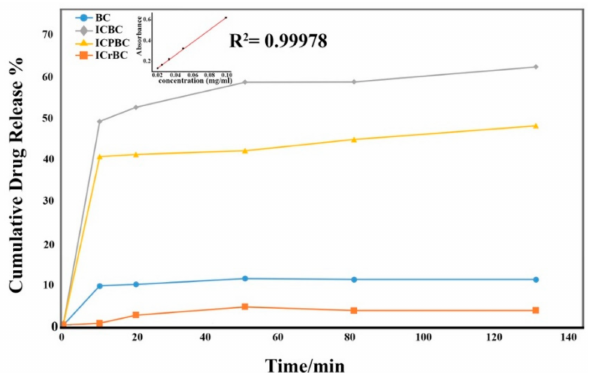
Figure 6. In vitro release profiles for Pure BC, and the drug loaded samples; ICBC, ICPBC and